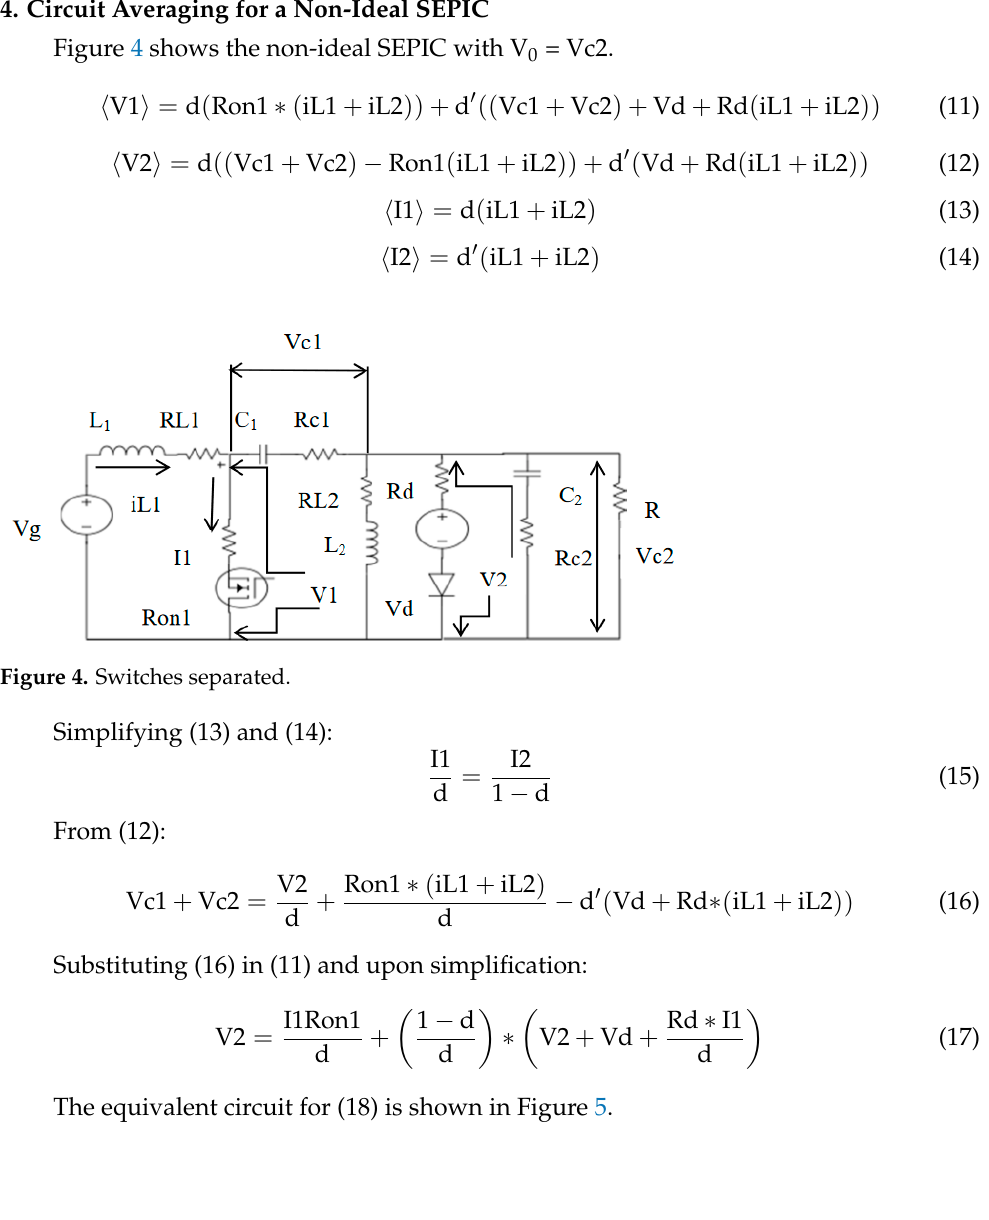
Figure 3. Equivalent switch network, where {1} is ˆdV1